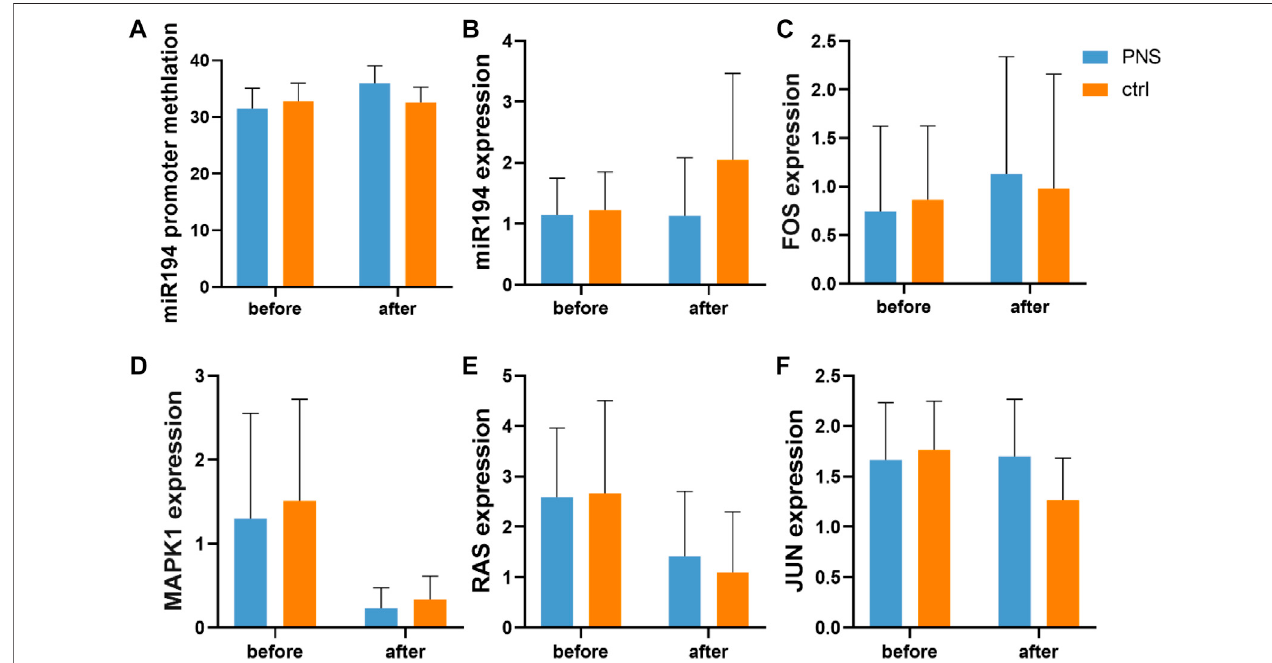
FIGURE 6 | Expression of key genes in the miR-194 promoter-miR914-MAPK pathway according to pyrosequencing and PCR.